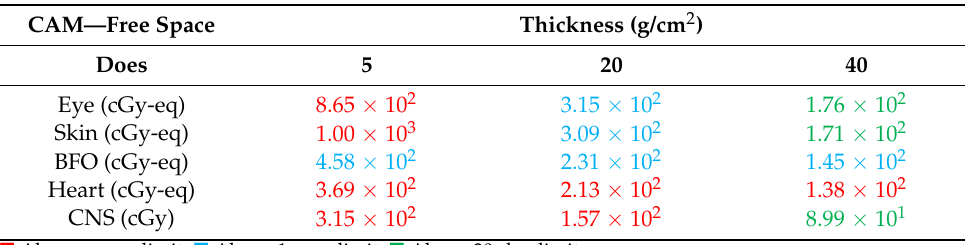
Table 2. Organ doses from 993/4 SPE for CAM on transit to Mars through free space behind various thicknesses of aluminum shielding.